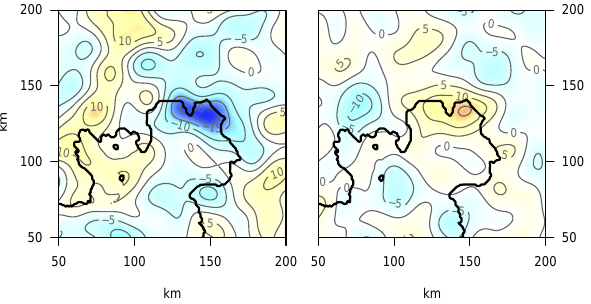
Figure 7. Mean bedrock noise fields for the early- and late-onset low-frequency PIG simulations. The contour interval is 5m. The mean noise field computed for the four early onset simulations shows a lowering of the ridge where the glacier trunk crosses the initial grounding line (left), while the corresponding field for the eight late-onset simulations shows a rise.